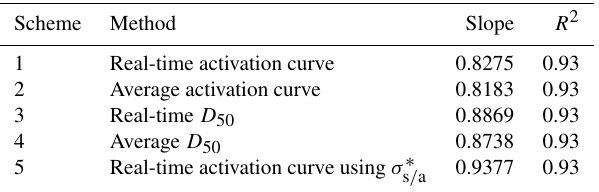
Table 5. The overview of methods used in the N CCN prediction based on AMS